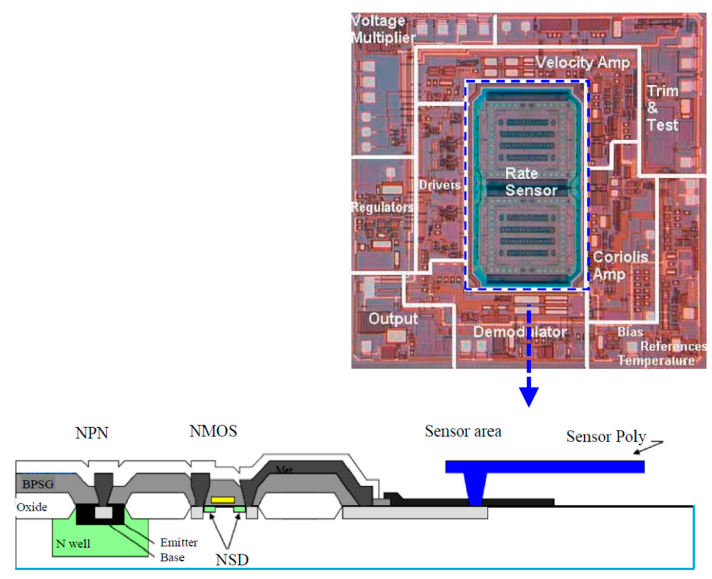
Figure 3. Die photo of an integrated gyroscope by Analog Devices [15].